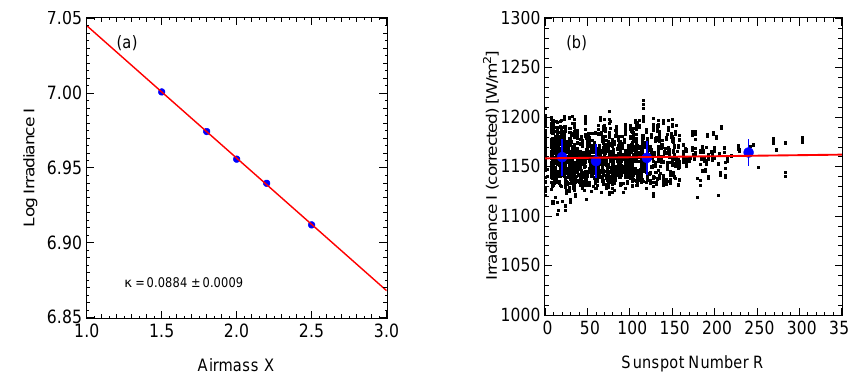
14 Fig. 7. (a) Estimate of the extinction coefficient κ defined by I ( X )= I 0 exp( − κX ) from a linear regression (red line) to the medians (blue circles) of the solar irradiance I at different airmass values X for all data taken at Cerro Montezuma. (b) Best estimate of the variation of solar irradiance I with sunspot number R for the Cerro Montezuma data during months JJA at all airmass values and for days with low water content and low aureole brightness, showing an increase of I with R of the order of 0.1% between solar maxima and minima. The values of the median and the variance in four R intervals are shown (blue circles with error bars) , as is the result of a linear fit to the data (red line) .